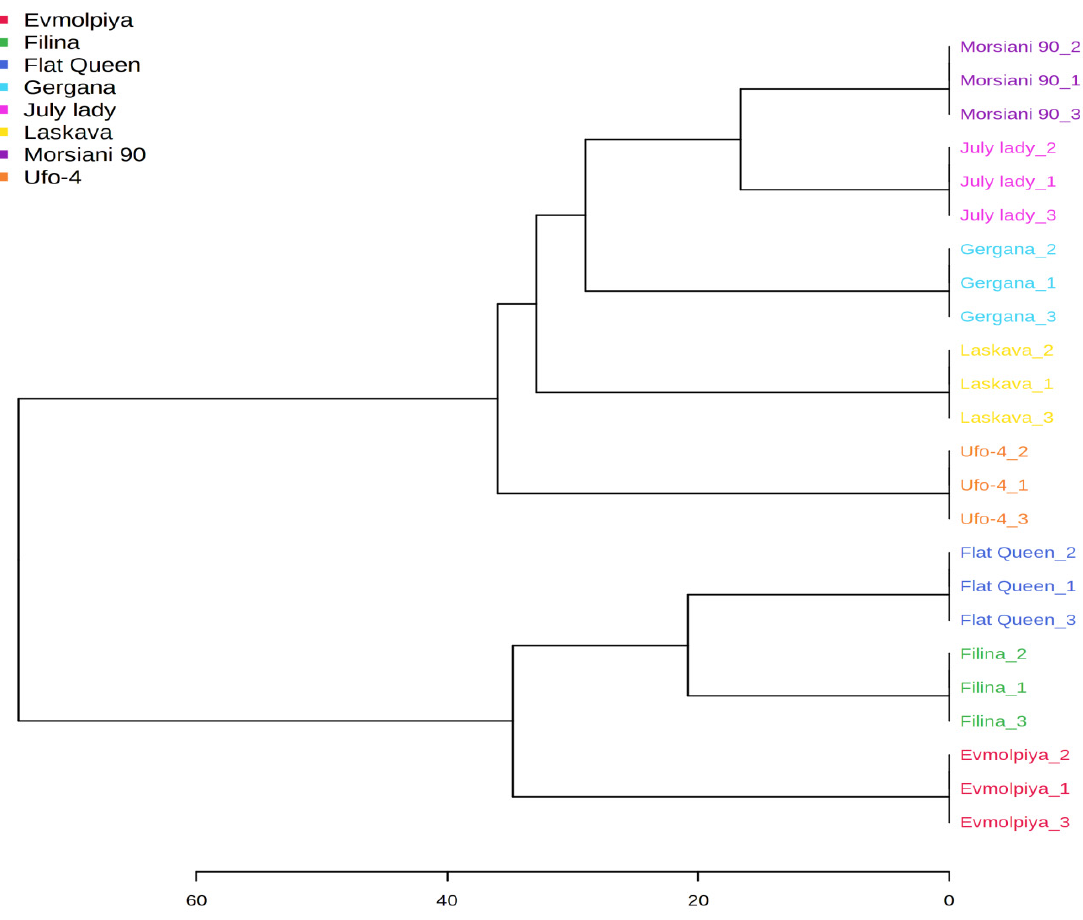
Figure 6. Clustering result of peach varieties shown as a dendrogram (by Euclidean distance measure, and Ward‘s clustering algorithm).